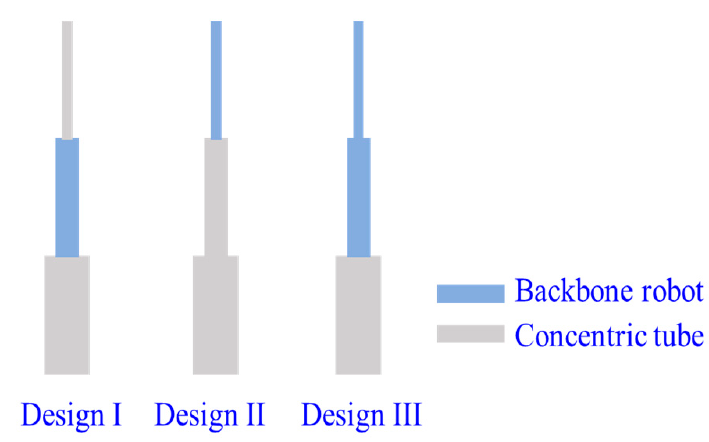
Figure 14. Three designs of the backbone-concentric-tube CCRs [108].